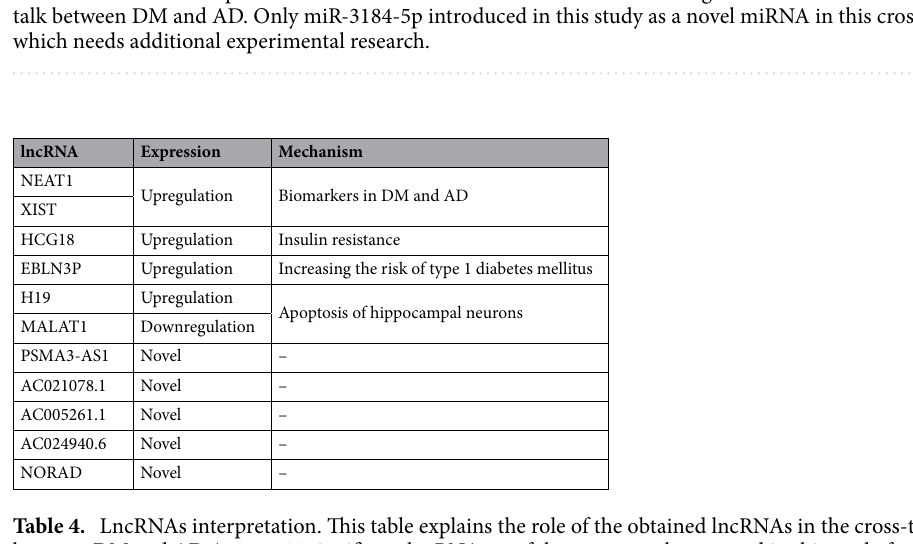
Table 4. LncRNAs interpretation. This table explains the role of the obtained lncRNAs in the cross-talk between DM and AD.Among 11 significant lncRNAs, 5 of them are novel, proposed in this study for future experimental analysis